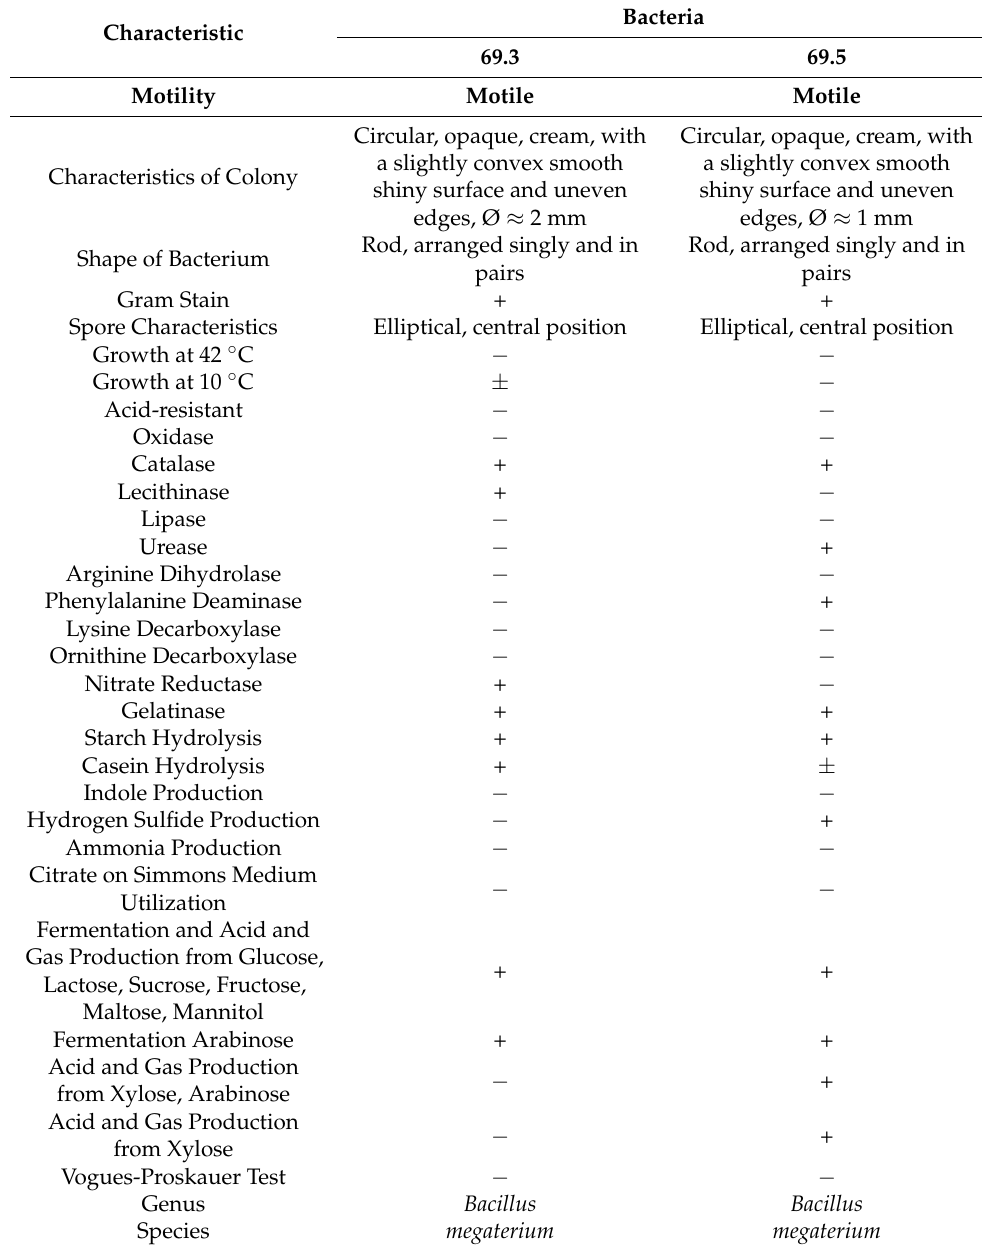
Table 2. Phenotypic characterization of two bacterial isolates (69.3 and